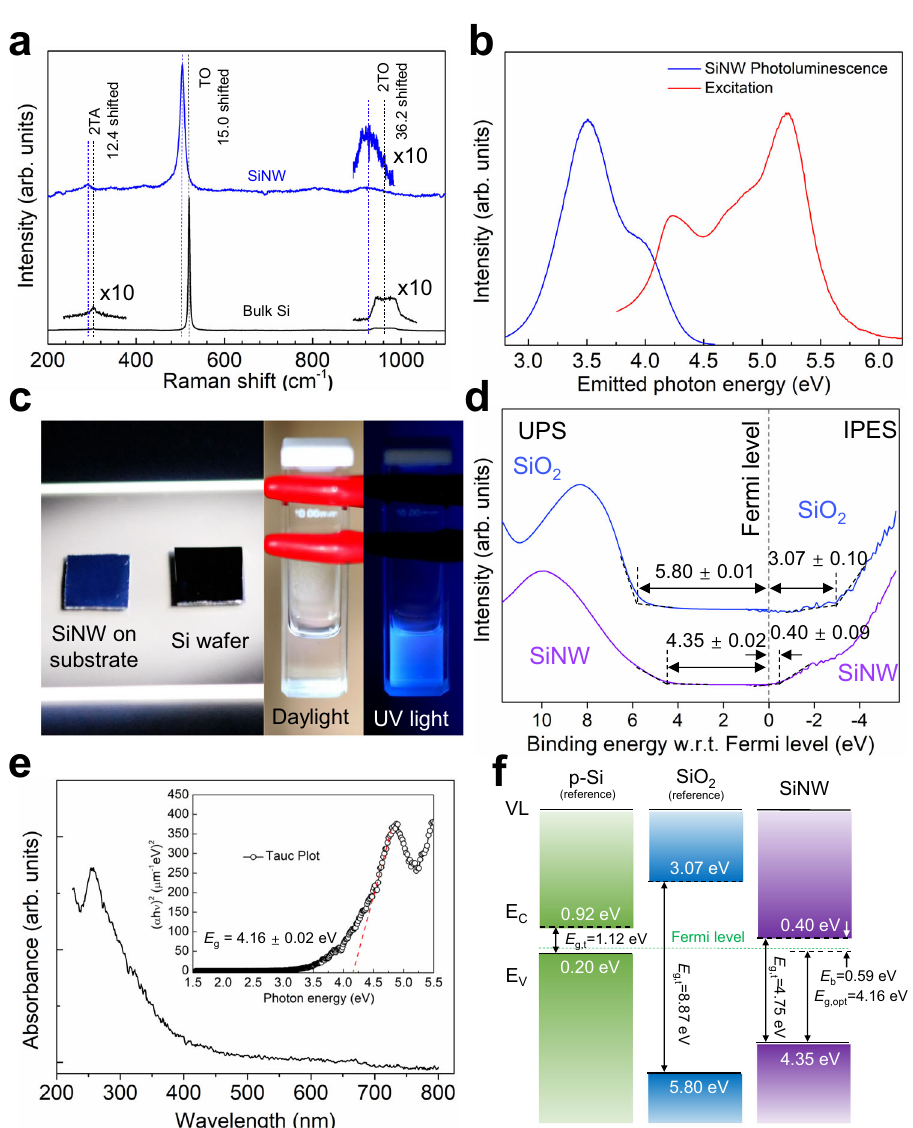
Fig. 3 Optical properties and bandgap of the vertically aligned ultra-narrow SiNWs. a Raman characterization result showing clear SiNW peaks with redshift. b Photoluminescence spectrum of ultra-narrow dispersed in ethanol with excitation energy of 5.17 eV. c Photographs of the as-fabricated SiNWs on Si and SiNWs dispersion in ethanol under UV light. d Combined UPS and IPES spectra show the quasi-particle bandgap of SiNWs with the conduction/ valence band offsets. e UV – vis absorption spectrum of SiNWs. Tauc plot indicates the direct bandgap transition for SiNWs. f Energy-level diagram of the SiNWs derived from UPS, IPES, and PL. E g,t , E g, opt and E b are transport bandgap, optical bandgap, and binding energy,